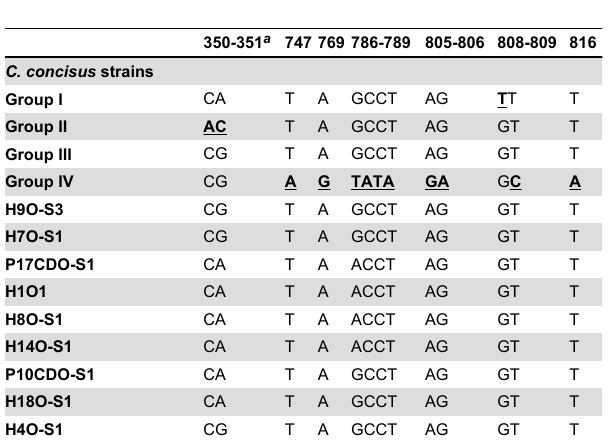
Table 6. Prevalence of zot 808T , zot 350-351AC and zot Multiple in patients with IBD and